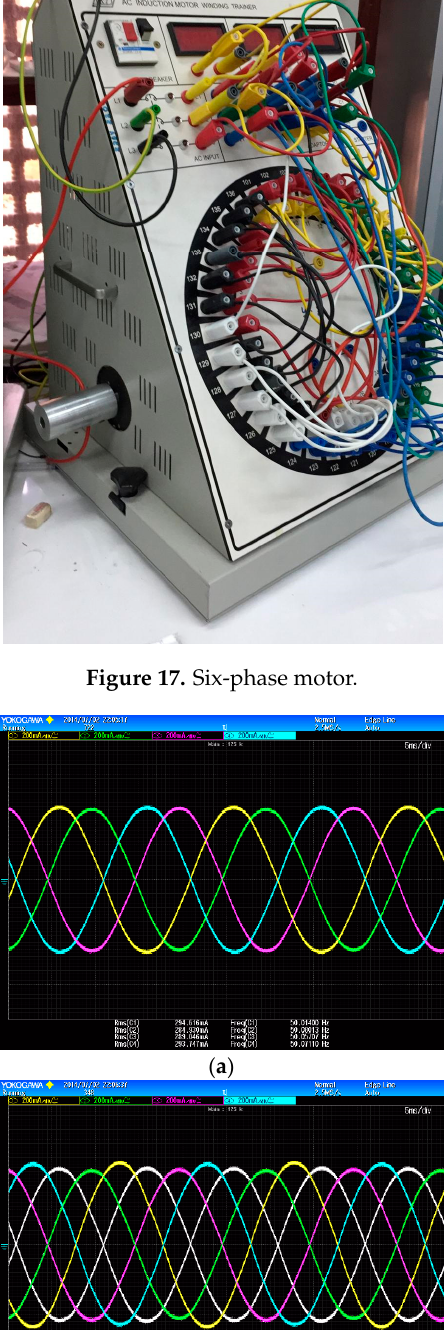
Figure 18. ( a ) Symmetrical Six-phase motor under no-load condition; ( b ) symmetrical motor under full-load condition.